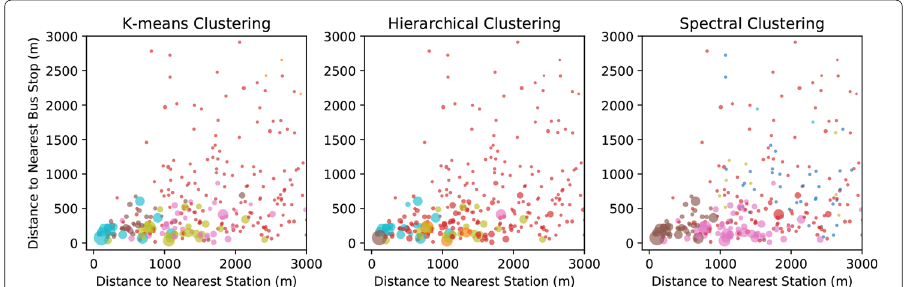
Fig. 13 Scatterplot of the relationship among the distances to the nearest train stations (x-axis) and bus stops (y-axis), the mean of the four train-bus synergy scores (size), and the group membership for each clustering method (color). Zoomed into distances within 3 km (plots of the full range appear the Additional file